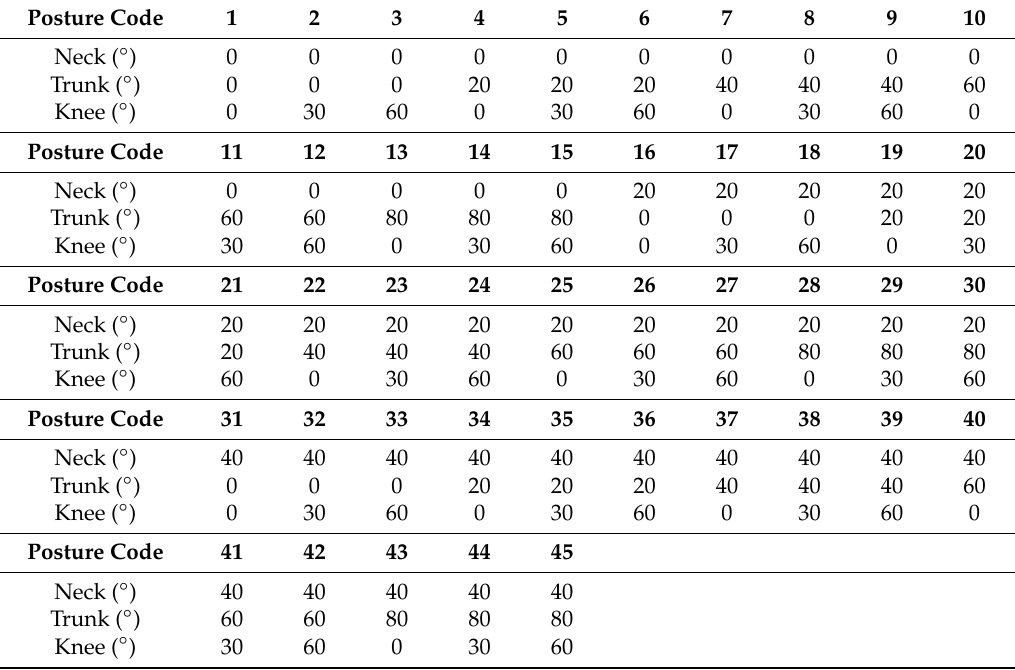
Table 2. Description of the 45 combined postures in terms of the neck flexion (0 ◦ , 20 ◦ , and 40 ◦ ), trunk flexion (0 ◦ , 20 ◦ , 40 ◦ , 60 ◦ , and 80 ◦ ), and knee flexion (0 ◦ , 30 ◦ , and 60 ◦ )